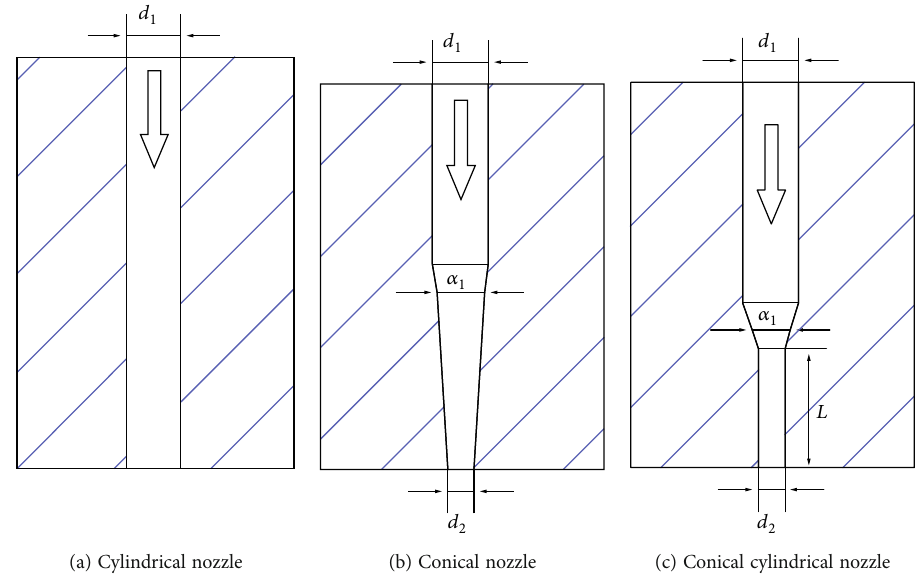
Figure 5: Geometry diagrams of